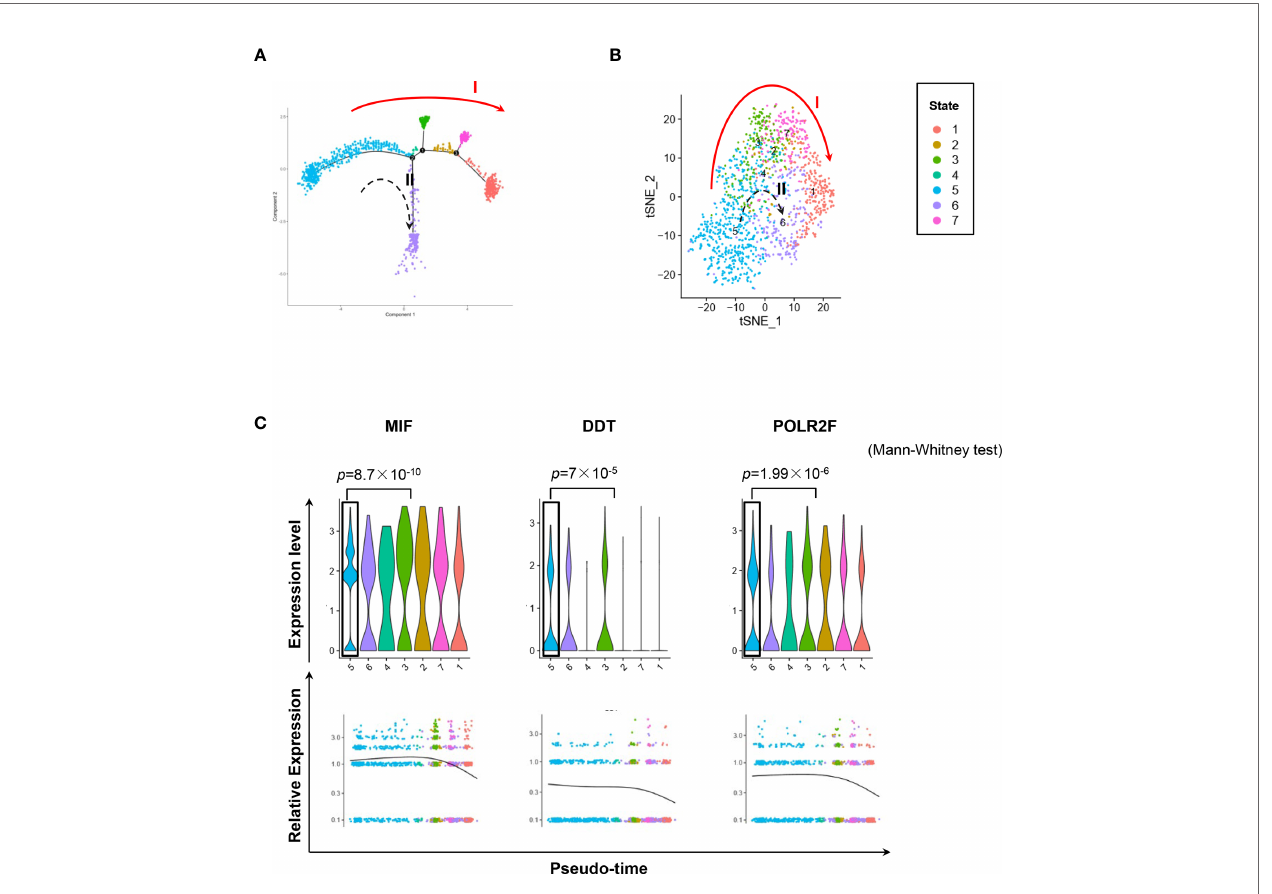
FIGURE 5 | Single-cell transcriptomics exploring the trajectories of MIF High to MIF Low MM cells. (A) Sc-RNA seq explored the transcriptomic pro fi les associated with the development of MM cells in extramedullary microenvironment. MM cells labeled with the anti-human CD138 antibody were separated by fl ow cytometry from the spleen of an ARD MM-bearing mouse. A total of 1,424 extramedullary MM cells were plotted. The branching tree of MM cell trajectories de fi ne seven color-coded cell clusters or states: putatively developing from cluster #5 (initial state), proceeding along with several unstable intermediate states (clusters #3, #2 and #7, or cluster #4), and fi nally reaching cluster #1 or #6 (end state), as indicated by the red solid arrow (trajectory I) and black dotted arrow (trajectory II, probably transitional), respectively. (B) tSNE plots show seven clusters. Arrows I and II indicate the two putative cell-state transition trajectories, respectively. (C) Cluster #5 could reasonably be the initial state, since it has signi fi cantly higher expressions of MIF and two co-expressed genes DDT and POLR2F, as shown in the violin plots and scatter plots of pseudotime estimation. Likewise, the putative end state, especially cluster #1, has the least expression of MIF, DDT and